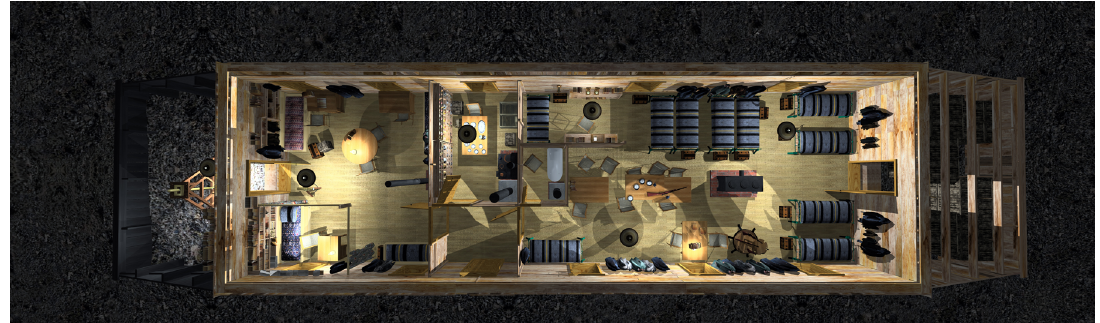
Figure 17. Floor plan of the computer reconstruction of the Greely station